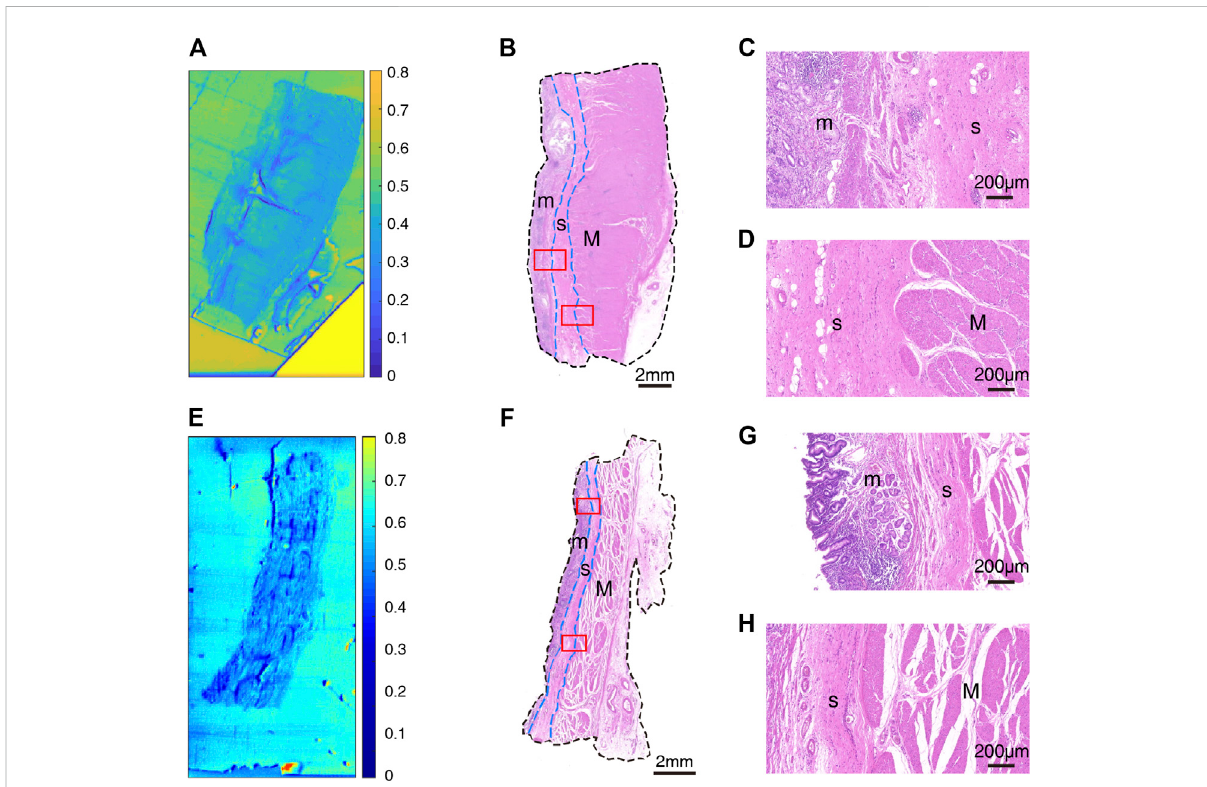
FIGURE 5 Images of GC sample: (A) THz image, (B) H&E-stained slice, and (C,D) H&E-stained images corresponding to the region indicated by the red squarein (B) ofT4; (E) THzimage, (F) H&E-stained slice,and (G,H) H&E-stainedimagescorrespondingtotheregionindicatedbytheredsquarein (F) ofT5.InH&E-stainedimages, “ m ” indicates “ mucosa ” , “ s ” indicates “ submucosa ” and “ M ” indicates “ muscularlayer ” .Inimages (B,F) ,theboundariesof mucosa, submucosa, and muscular layer are outlined with dashed blue lines. (C,G) are boundaries between mucosa and submucosa. (D,H) are boundaries between submucosa and muscular layer.